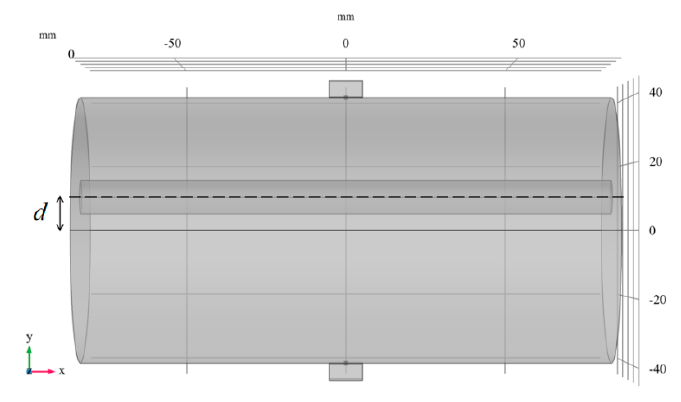
Figure 11. d represents the distance from the center of the artery to y = 0.